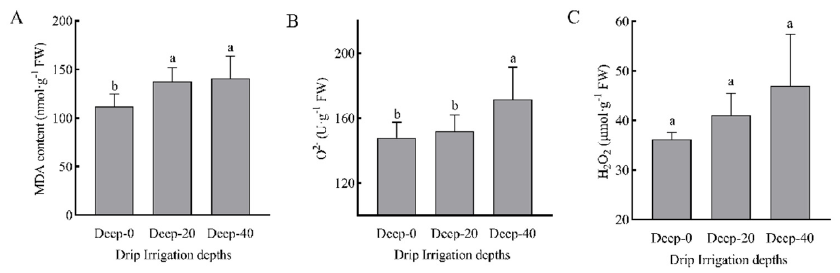
Figure 9. Malonaldehyde and reactive oxygen species contents in the crown of alfalfa plants under three drip irrigation depths. ( A ) Malonaldehyde, ( B ) superoxide anion (O 2 − ), and ( C ) hydrogen peroxide (H 2 O 2 ). Different lower-case letters above bars indicate a significant difference between irri ‐